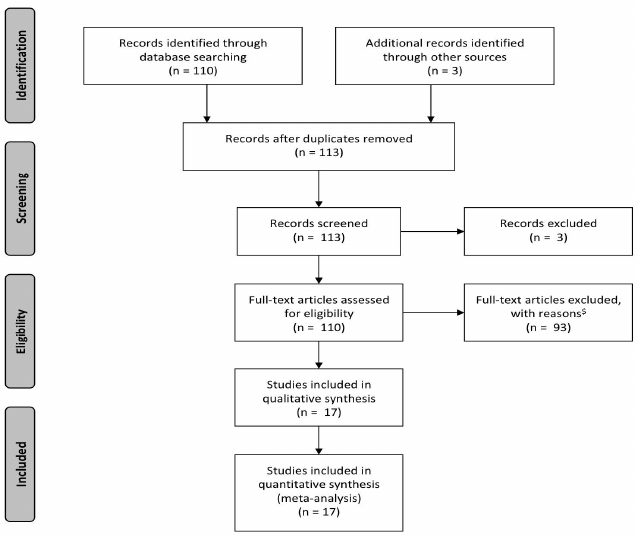
Figure 1. The PRISMA flow chart of evaluation and critical inclusion of the reviewed reports. $ : not reporting on minimally invasive bimanual fetal surgery.